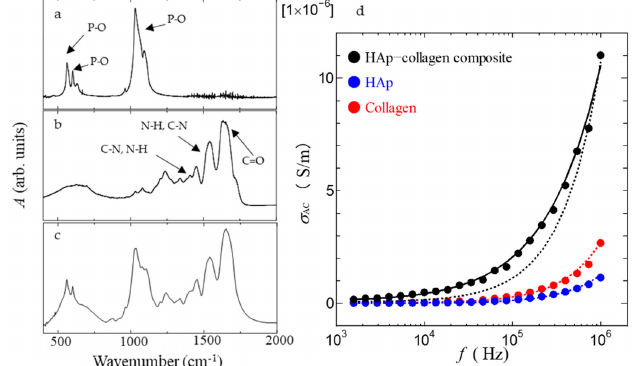
Figure 6. FT-IR spectra and impedance characteristics of HAp-collagen composite film. FT-IR spectra of ( a ) HAp film, ( b ) collagen film, and ( c ) HAp-collagen composite film. The graph in ( d ) is the frequency dependence of σ AC in the collagen film, the HAp film, and the HAp-collagen composite film at 150 ◦ C. Dotted lines show the results fitted by σ AC = σ 0 + ωε 0 ε ”. The solid line shows the results calculated by Equation